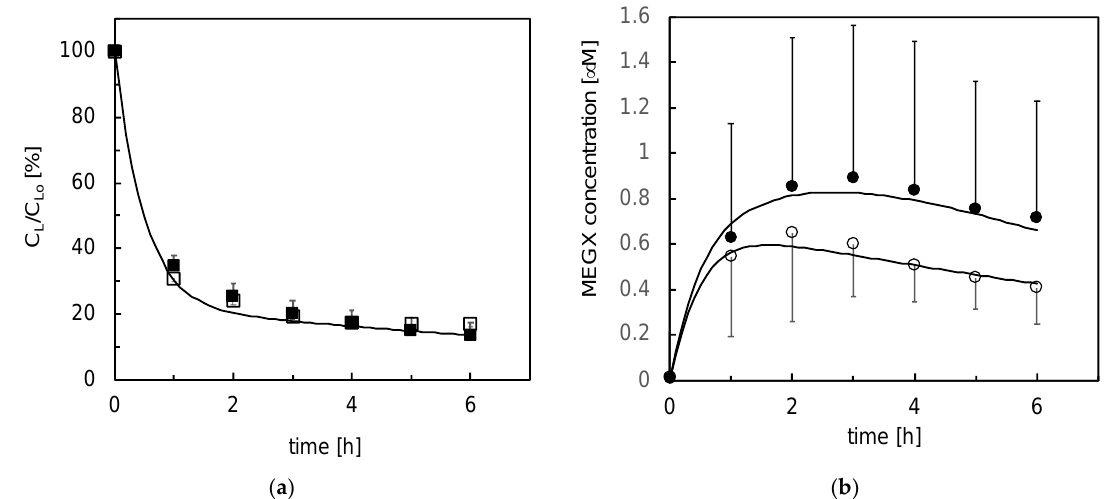
Figure 7. Histological sections of liver tissue from a 3D bioreactor and a patient with liver cirrhosis stained with hematoxylin and eosin: ( a ) tissue from a 3D bioreactor after 7 days of culture (magnification 320×); ( b ) tissue from the liver of a cirrhotic patient (magnification 400×). Details on tissue preparation can be found in the Materials and Methods Section.